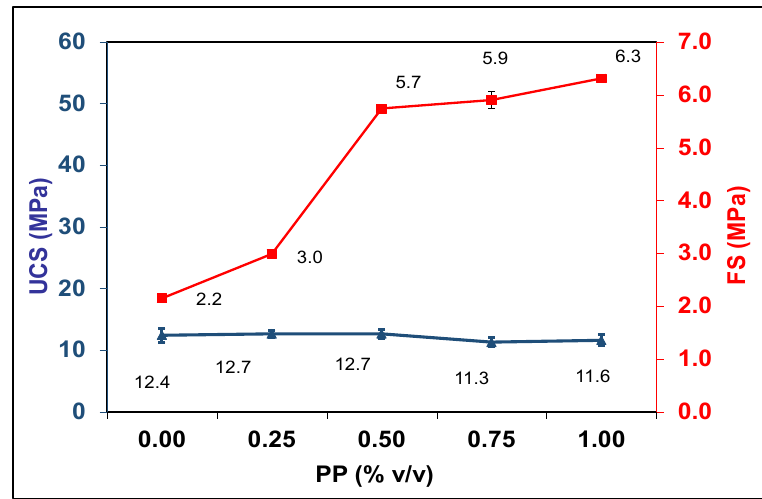
Figure 6. UCS and FS of geopolymers reinforced with PP fibers.